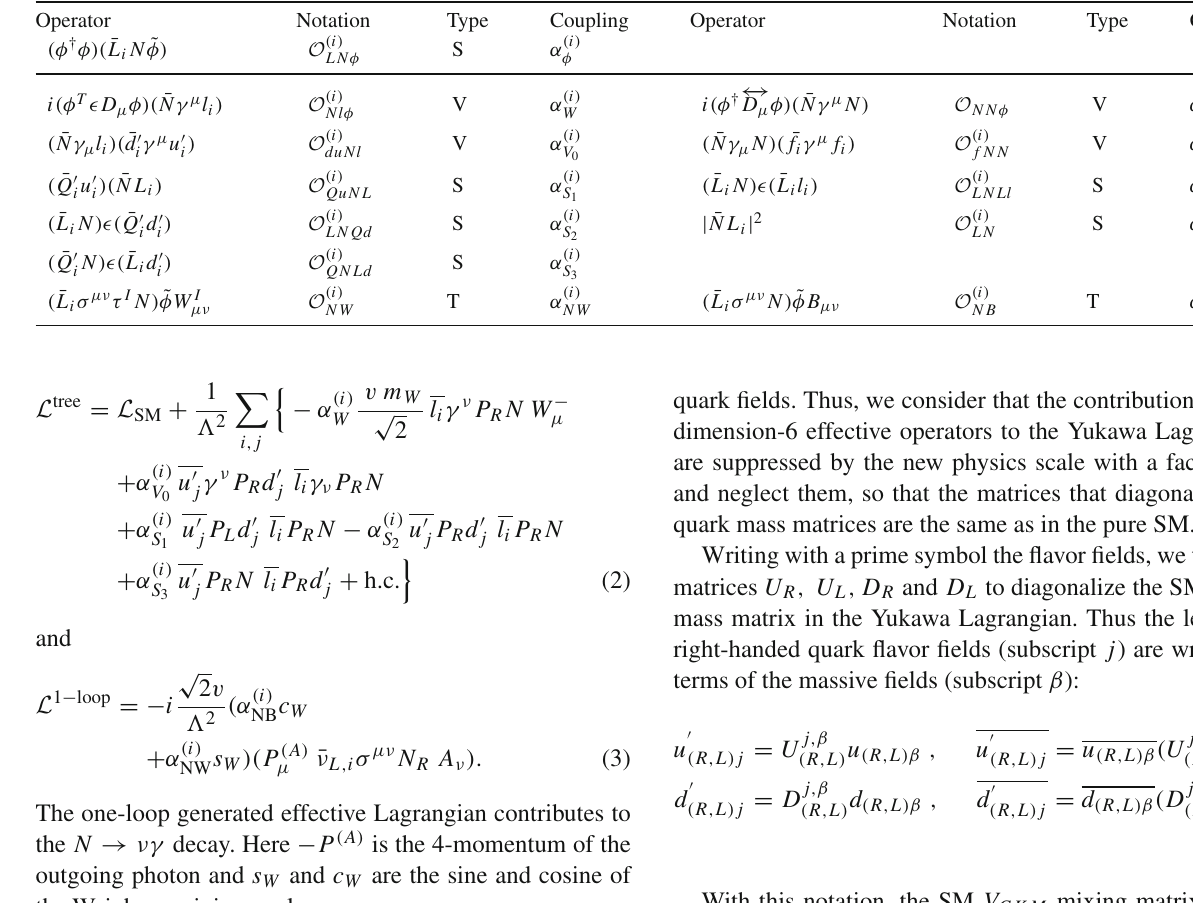
Table 1 Basis of dimension-6 baryon (and lepton) number conserving operators with a right-handed neutrino N [8,10]. Here l i , u (cid:5) L i , Q (cid:5) denote, for the family labeled i , the right-handed SU(2) singlet i and the left-handed SU(2) doublets, respectively (collectively f i ). The field φ is the scalar doublet, B μν and W I μν represent the U ( 1 ) Y and